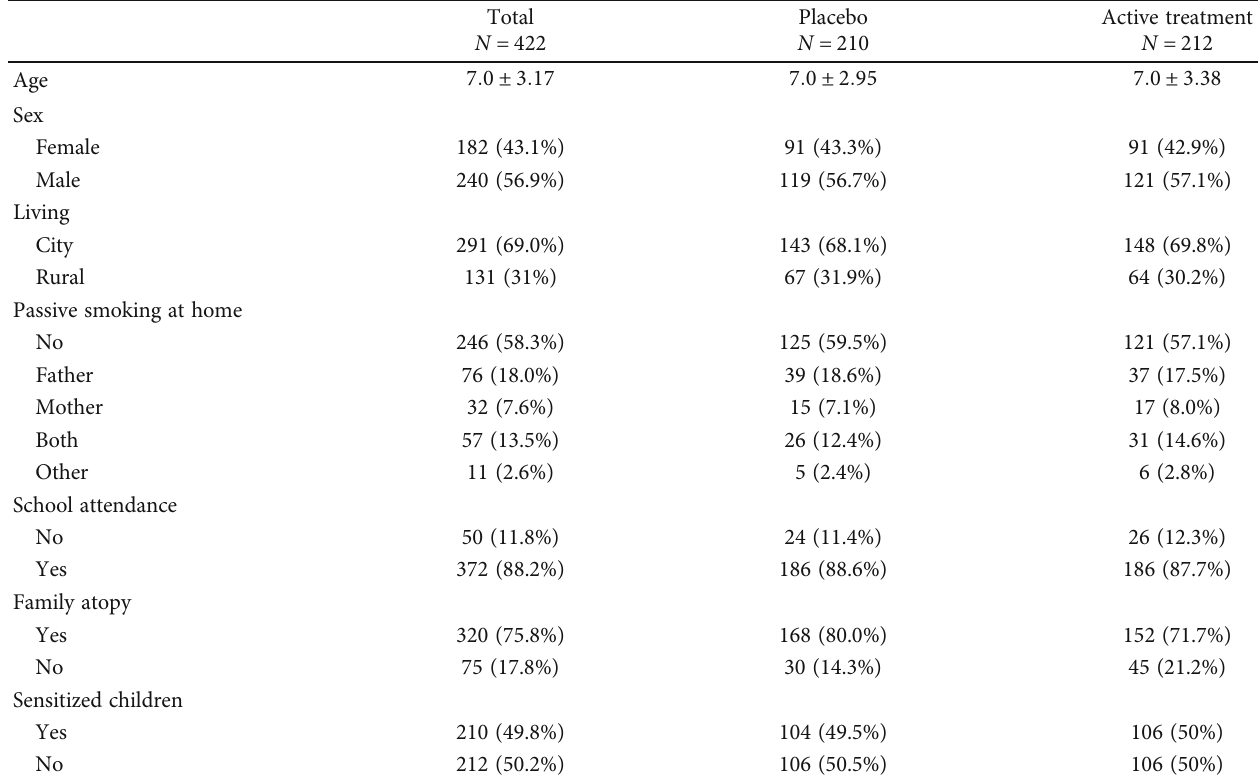
Table 1: Baseline characteristics.